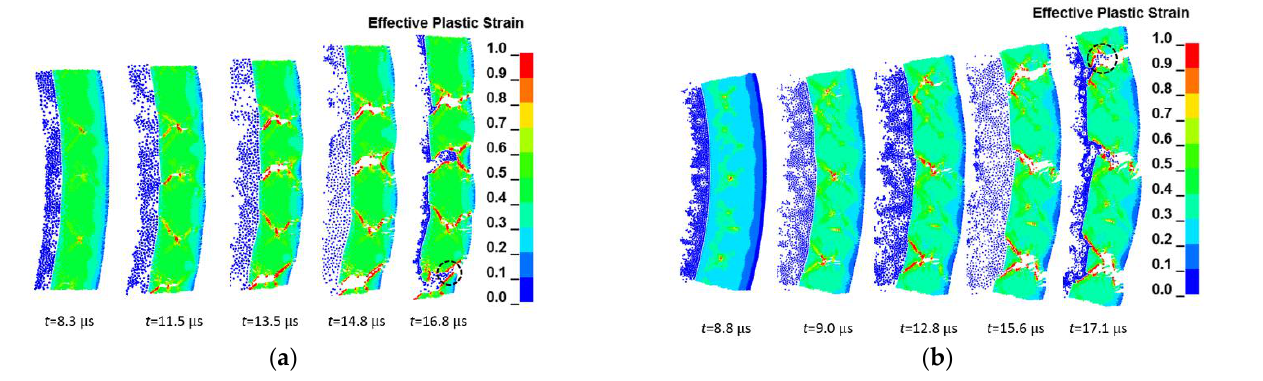
Figure 7. Simulation results of cylindrical shell expansion and fracture process with different R/h under a load of hollow RHT-901 explosive: ( a ) inner diameter 30 mm, shell thickness 4 mm; ( b ) inner diameter 30 mm, shell thickness 5 mm.